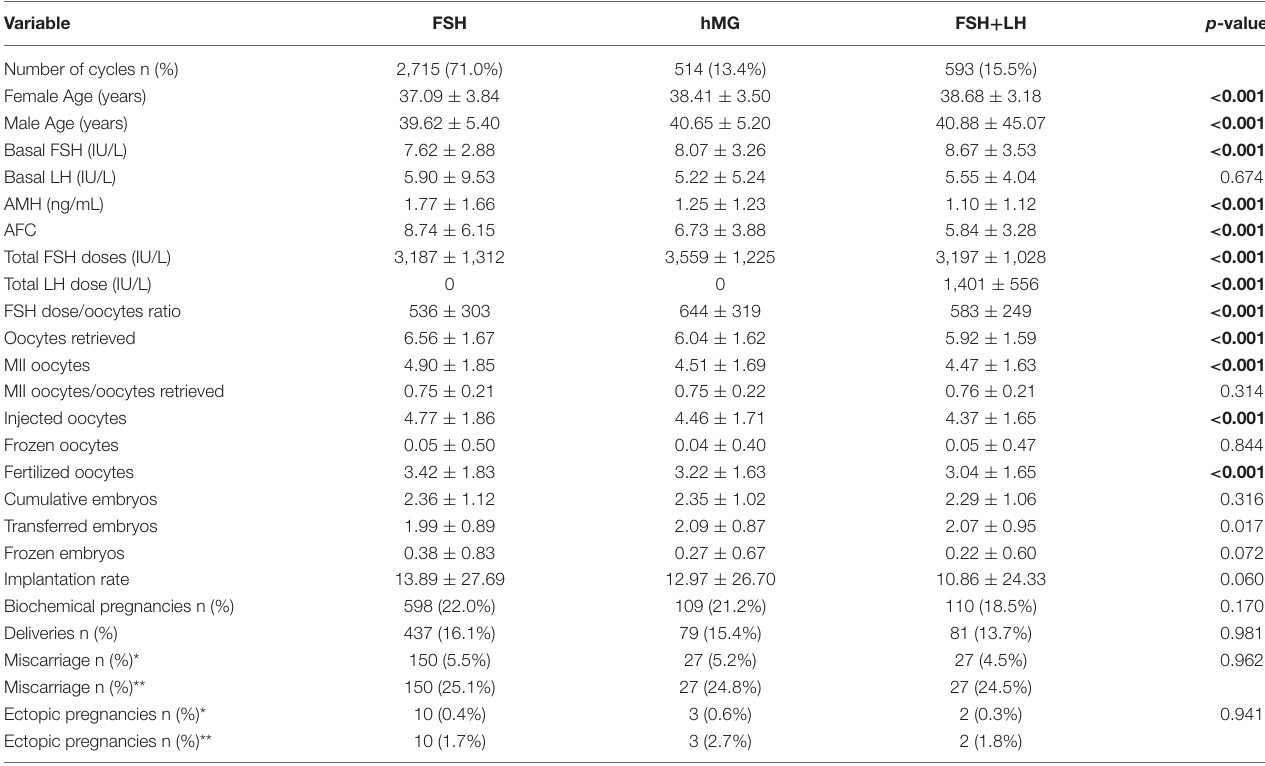
TABLE 3 | ART outcomes in “suboptimal” responder women.